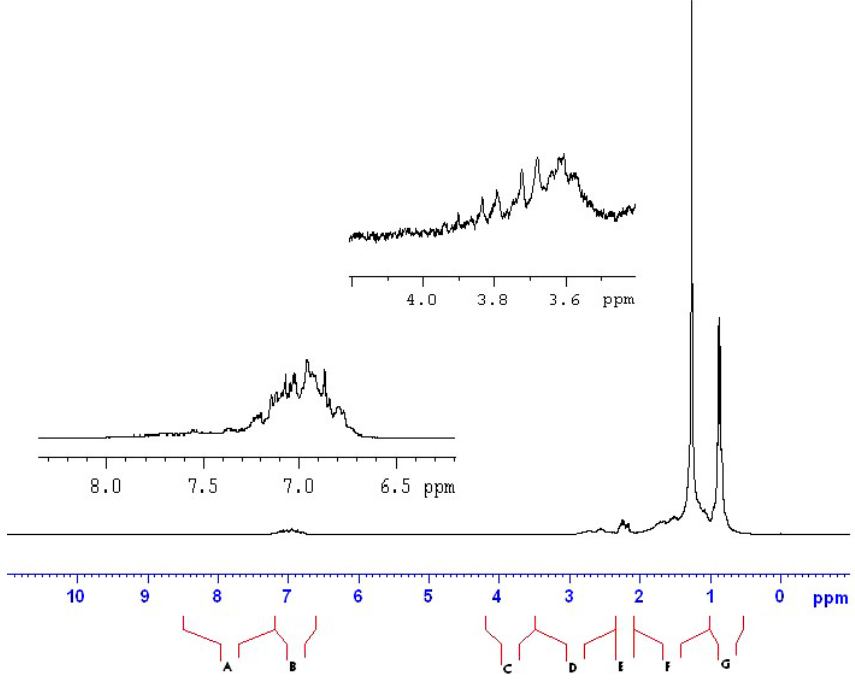
Figure 1. Typical 1 H NMR spectrum of a diesel fuel